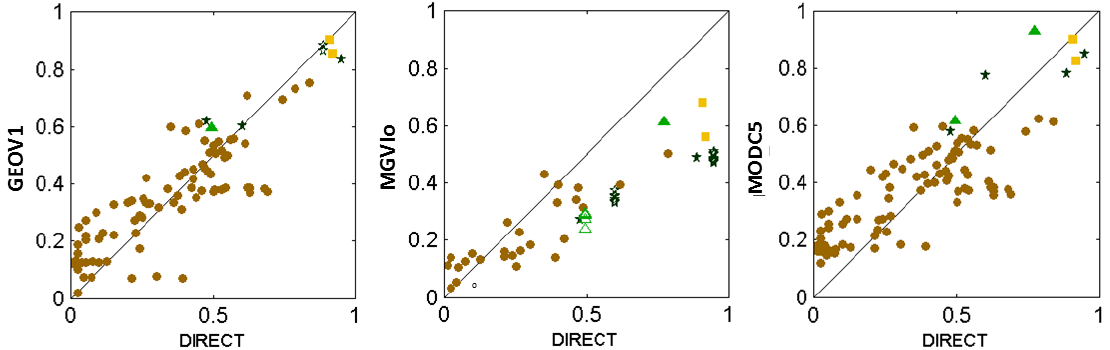
Figure 12. Comparison between the three product values and ground measurements acquired over the DIRECT sites (―interpolated method‖). Symbols correspond to the several biomes: Non Forest (brown circles), Deciduous Broadleaf Forest (yellow squares); NeedleLeaf Forest (green triangles) and Evergreen Broadleaf Forest (black stars). The corresponding open symbol is used when the ground data have derived from another year as compared to the ground measurements. In this case, the median value of the available products at the date in the year corresponding to the ground measurements acquisition computed across the considered time period (Table 2) is